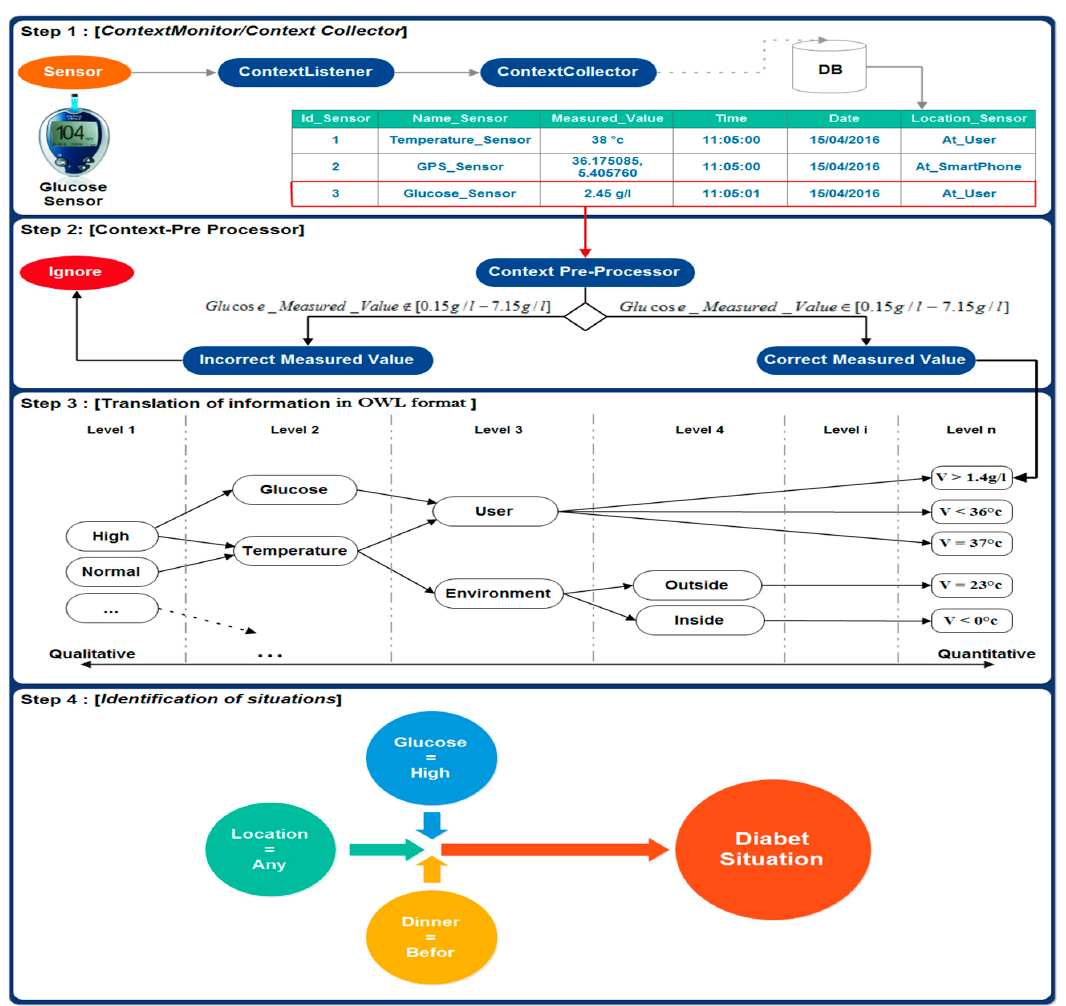
Figure 18. Ontology/rule ‐ based architecture simulation.